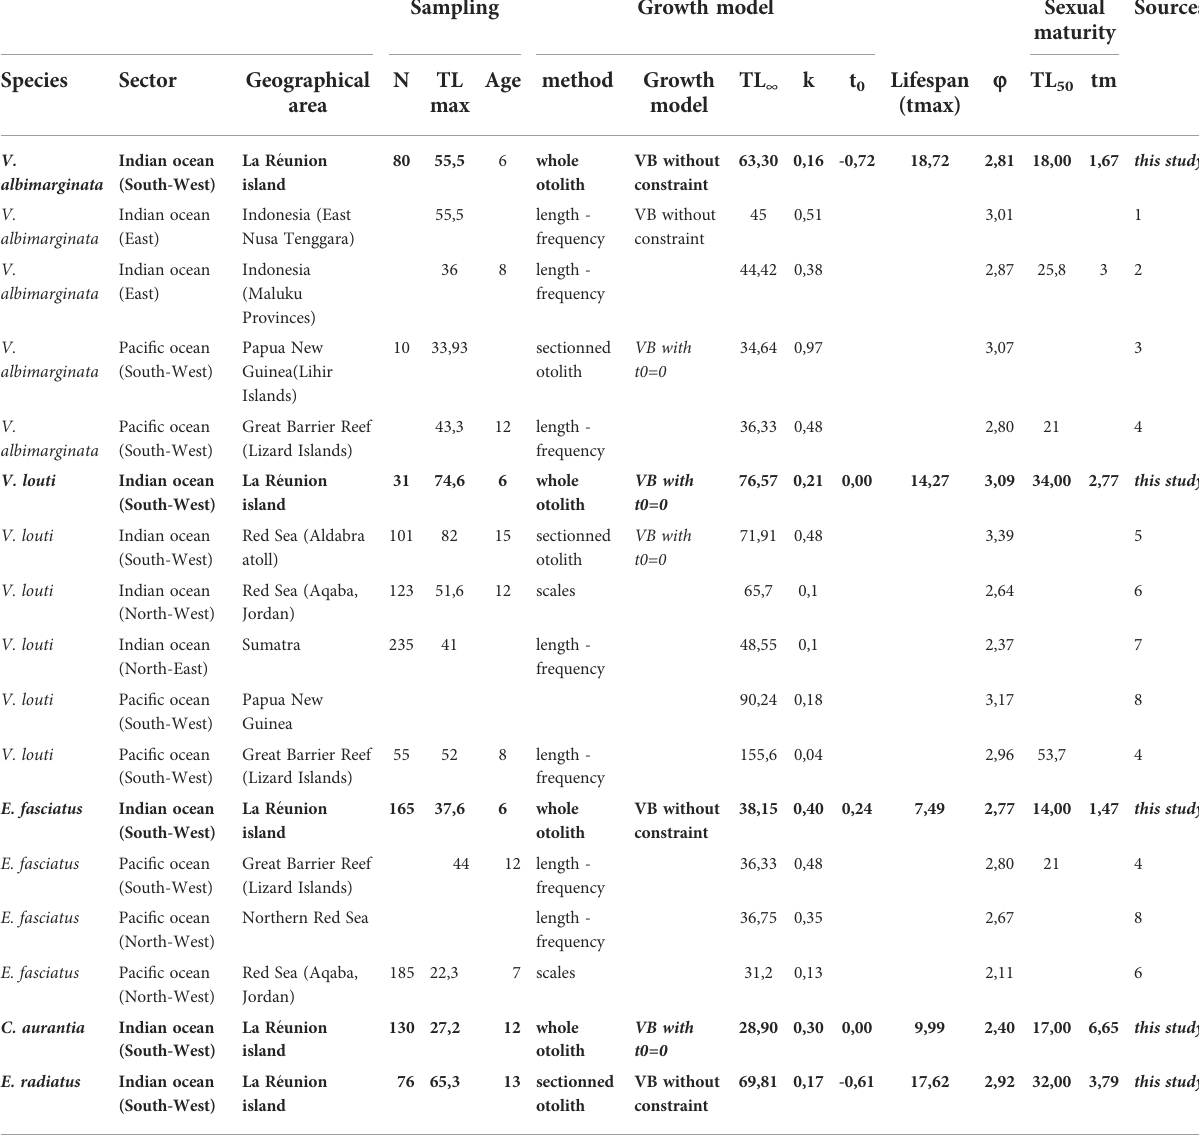
TABLE 2 Biogeographic comparison of the biological parameters of grouper species with the sampling details (number of samples, observed maximum TL and Age) of the growth model (model used with the type of data and the parameters of the growth model and growth performance index ( j )) and the fi rst sexual maturity (observed TL and Age (t m